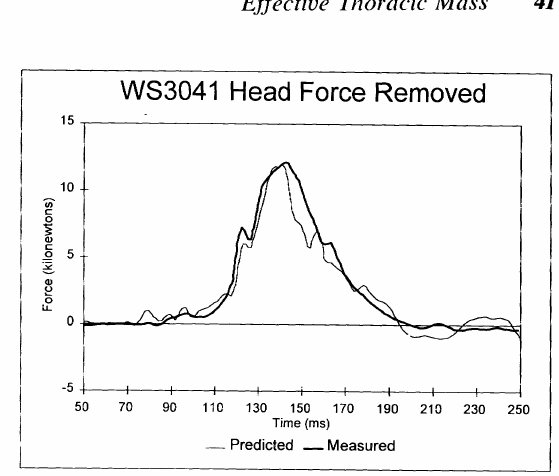
FIGURE 2 Measured and predicted forces with head force removal.